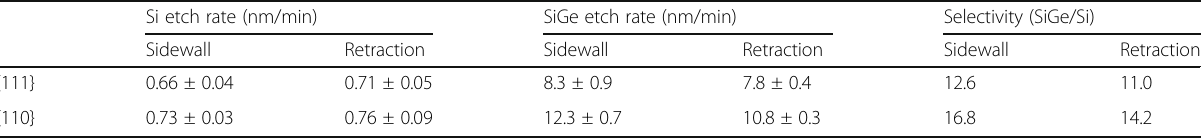
Table 2 Overview of the etching rates of Si and Si75Ge25 in PAA obtained by direct measurement of the sidewall-loss and indirect measurement of the spoke retraction. The errors represent the standard error of the slope. Last column shows the calculated selectivity ratios of